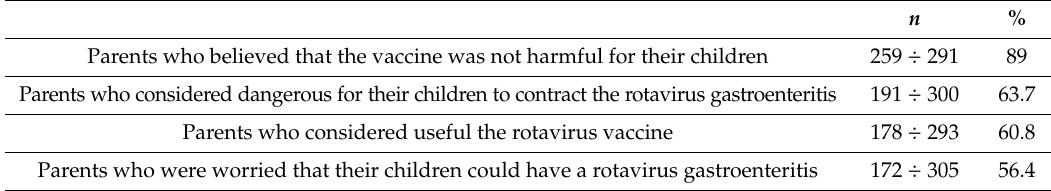
Table 4. Beliefs about rotavirus vaccination of the study respondents.